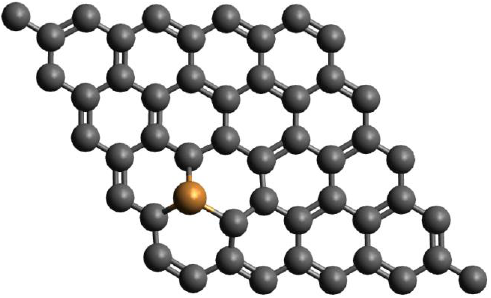
Figure 2. Equilibrium structure of C graphene atom substituted for Cu with the binding energy of − 3.59 eV/Cu atom. Grey balls stand for carbon atoms and orange for